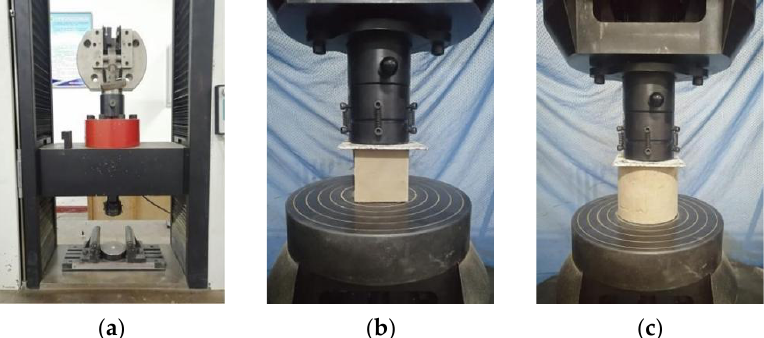
Figure 5. Specimen loading diagram: ( a ) loading instrument; ( b ) cube specimen; and ( c ) cylindrical specimen.